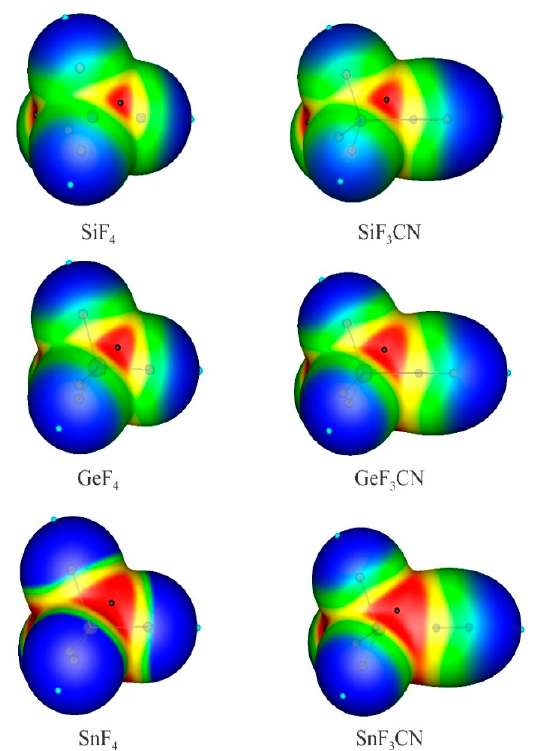
Figure 1. MEPs of isolated monomers. The color code, in kcal/mol, is: red > 40; 40 > yellow > 20; 20 > green > 0 and blue < 0. The small black and blue circles indicate surface maxima and minima, respectively. Table 1. Binding distances (R int , Å), X-M-F angles ( θ , °), M-X bond lengths (R M-X , Å) and their changes As Table 1 indicates, the M ··· A − binding distances of XF 3 M:A − complexes are in the range with respect to those of isolated MF 3 X monomers ( Δ R M-X , Å), interaction energies (E int , kcal/mol) of the anionic tetrel-bonded complexes, and the calculated local MEP minimum values (V S,min , kcal/mol) of the anions. Lewis Acid